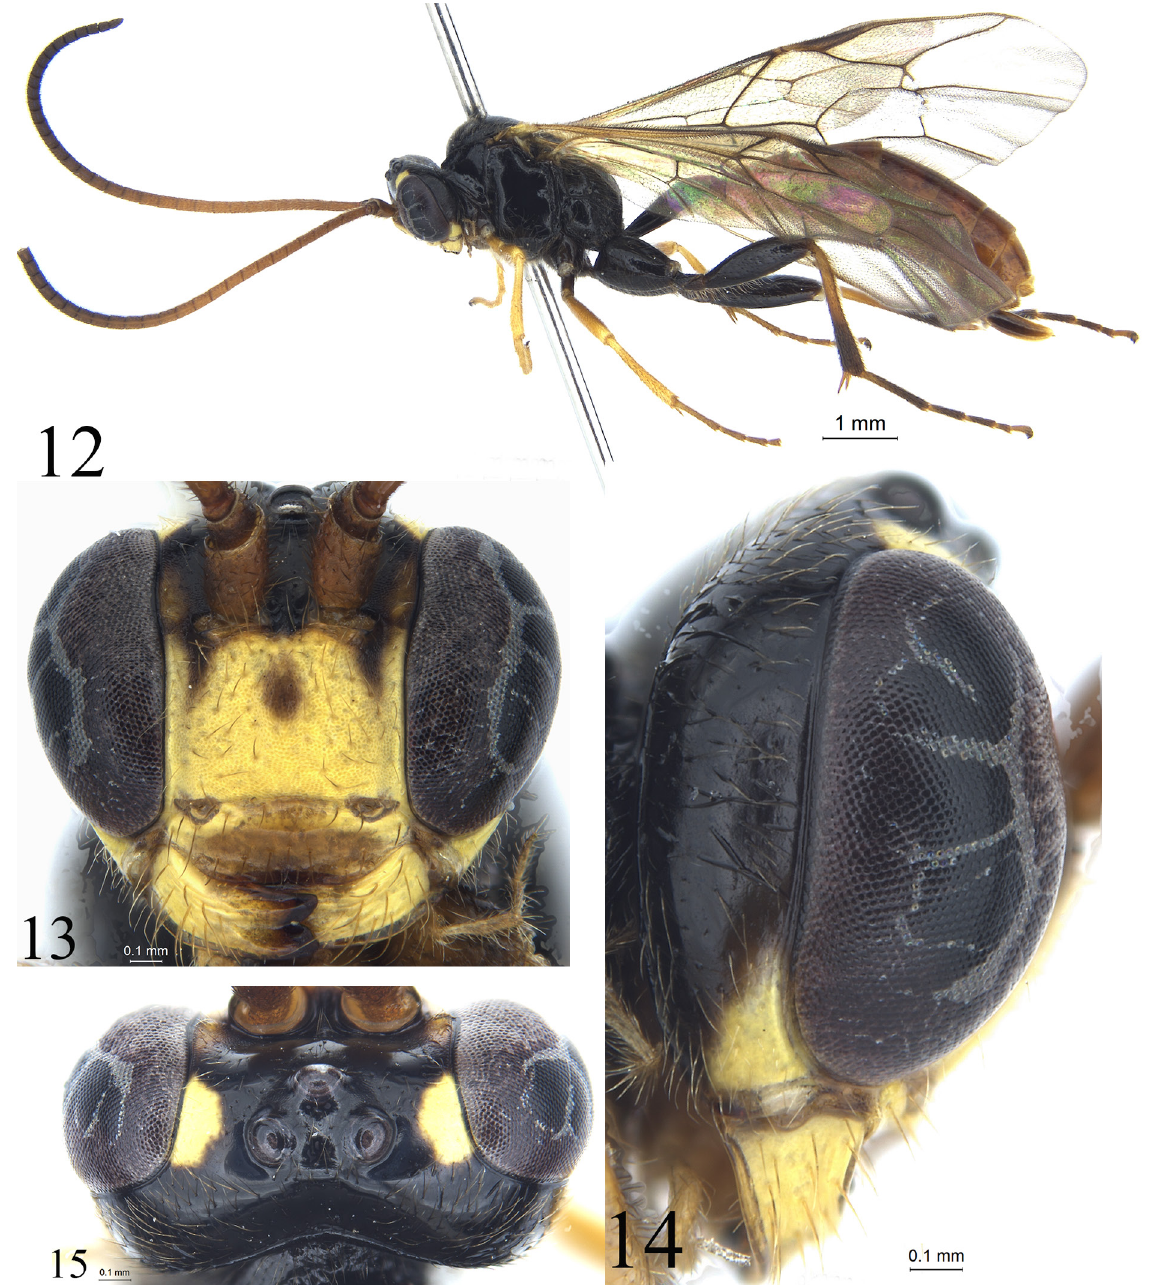
Figs 12–15. Ctenopelma lii Sheng, Sun & Li sp. nov., holotype, ♀ (GSFGPM). 12 . Habitus, lateral view. 13 . Head, anterior view. 14 . Head, lateral view. 15 . Head, dorsal